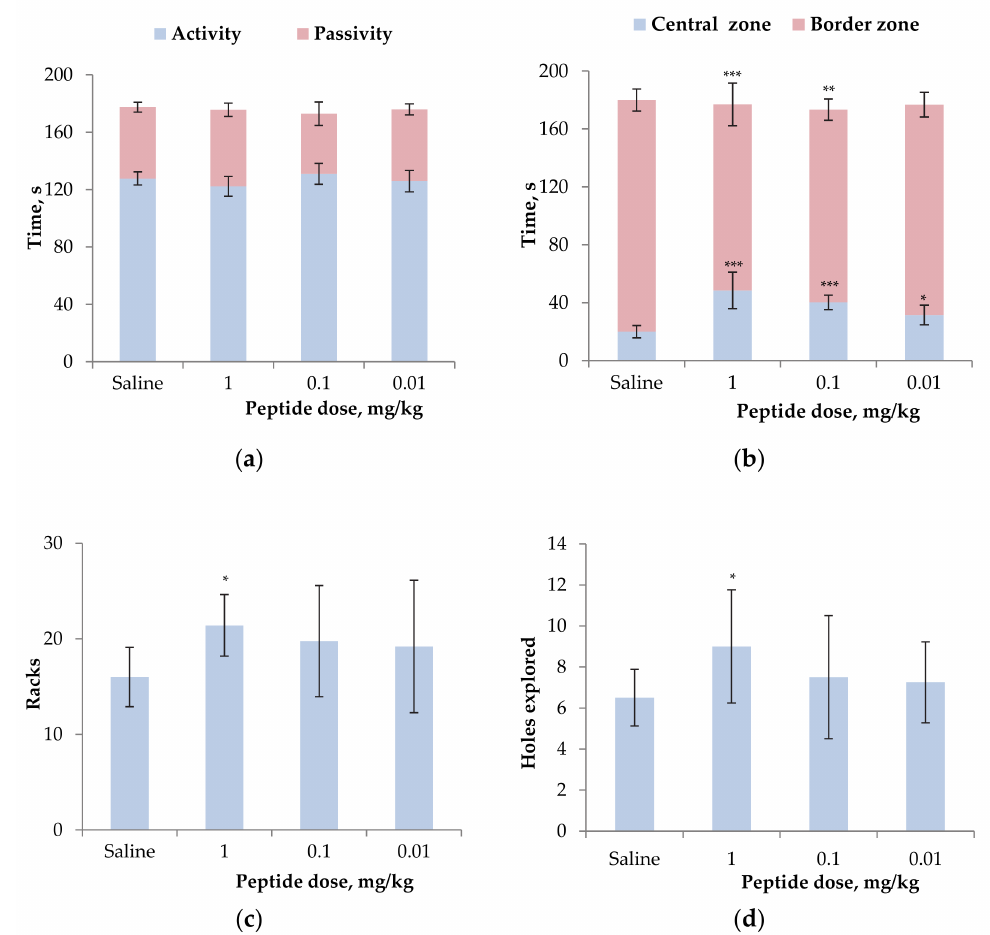
Figure 7. Effect of AnmTX Sco 9a-1 at the doses of 0.01–1 mg/kg on normal mouse behavior in the open field test: time of mouse activity or passivity ( a ), time spent in the central or border zone ( b ), the number of vertical stances ( c ) and peeps into the holes ( d ). Control animals received a similar volume of sterile saline. Results are presented as mean ± SD (n = 7–8). The significance of